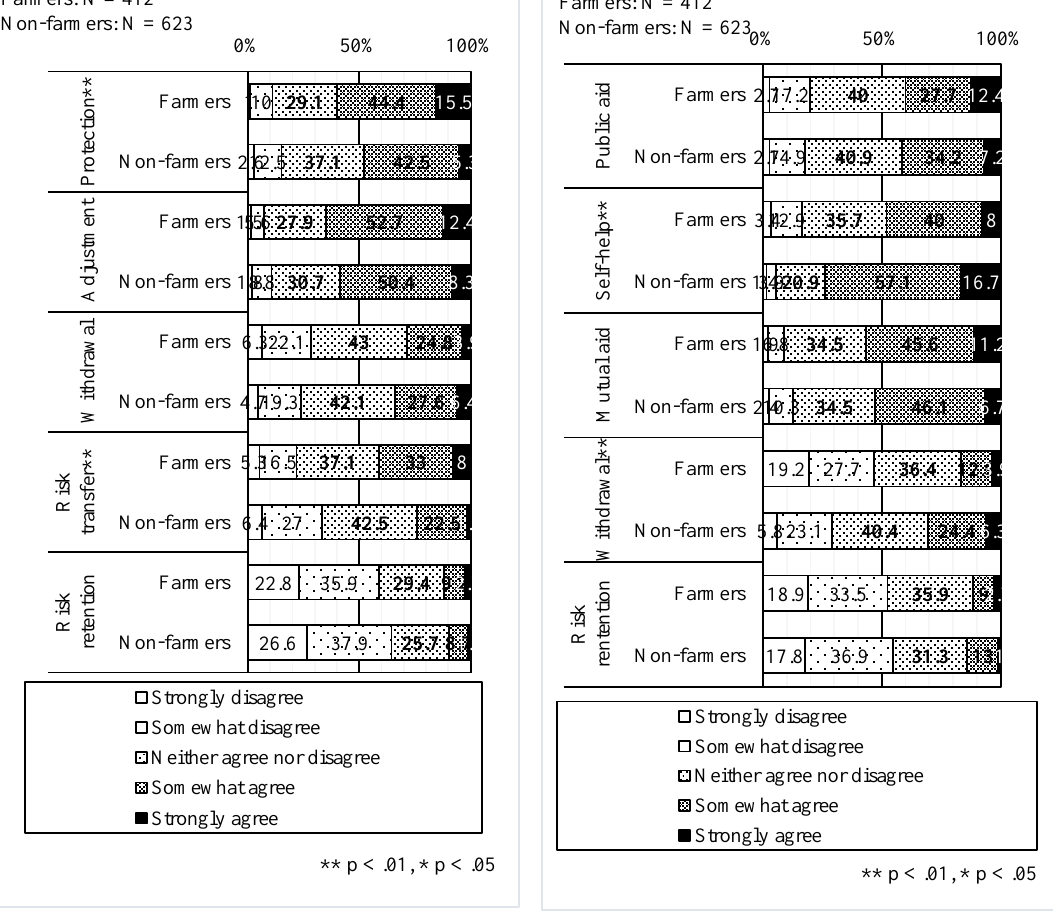
Figure 3. Preferences for and willingness to participate in adaptive measures among farmers and nonfarmers. ** p < 0.01, * p < 0.05, p -value: less than 0.05 is interpreted as statistically significant.